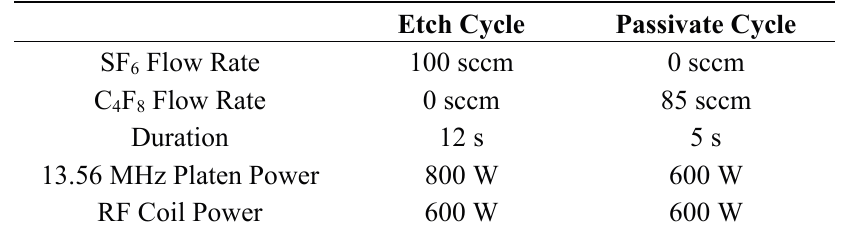
Table 2. Etch and passivation parameters used in the fabrication of the microfluidic